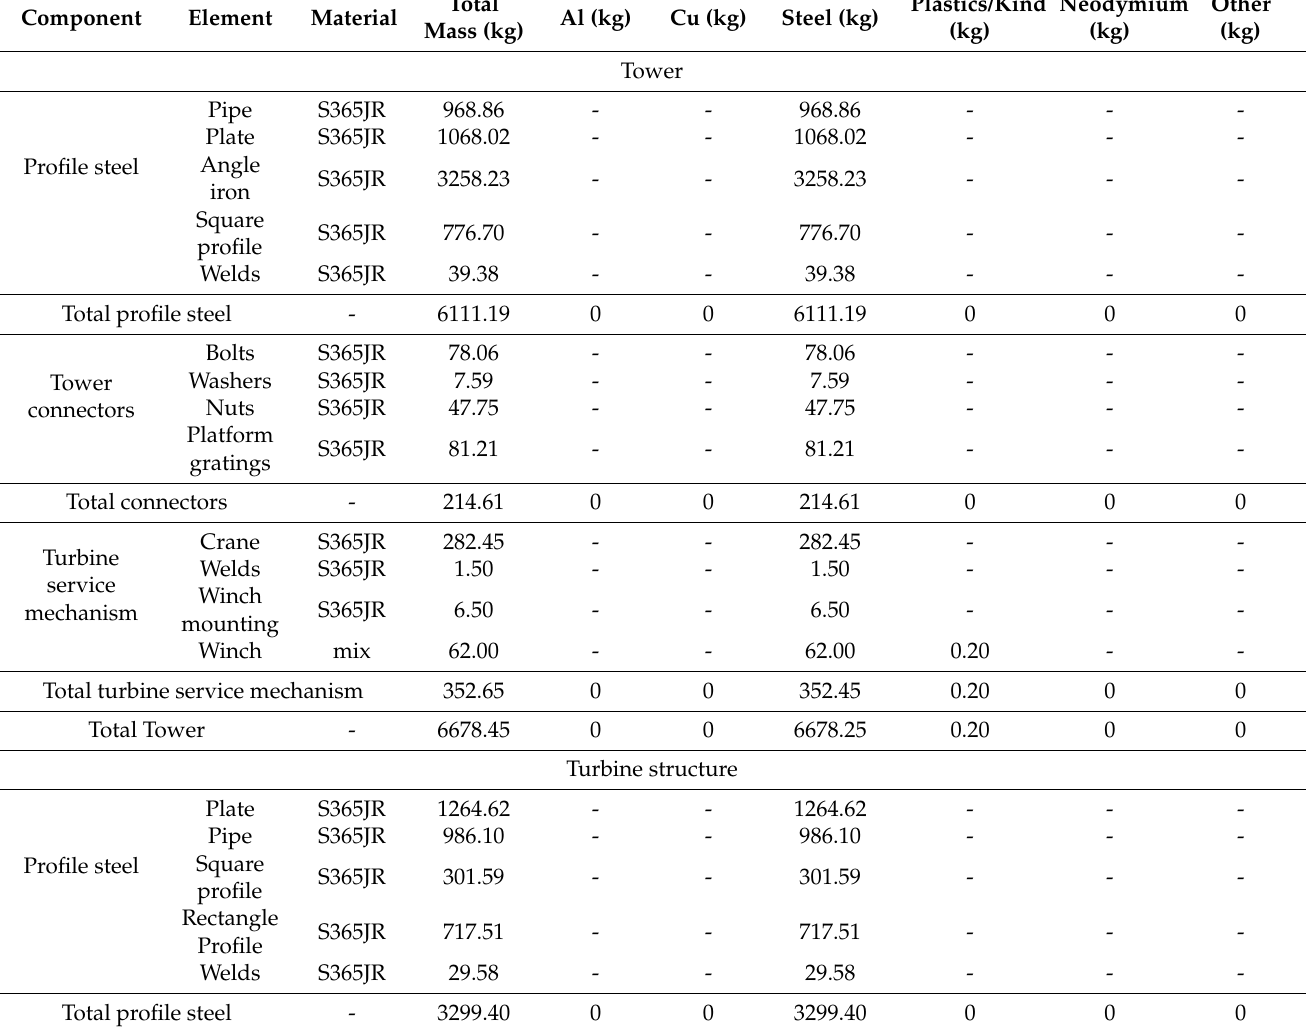
Table 1. Summary of materials and components of a 15 kW wind power